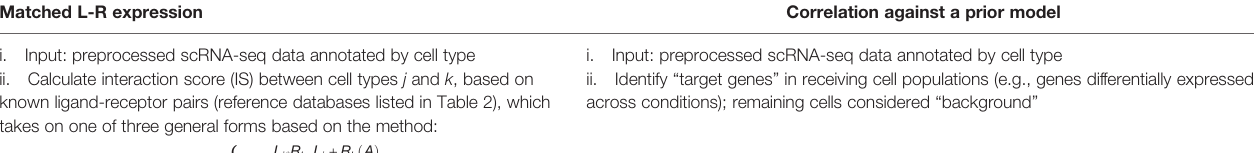
TABLE 1 | Comparison of matched ligand-receptor (L-R) expression algorithms versus correlation against a prior model (e.g., NicheNet) for inference of cell-cell communication from scRNA-seq. Matched L-R